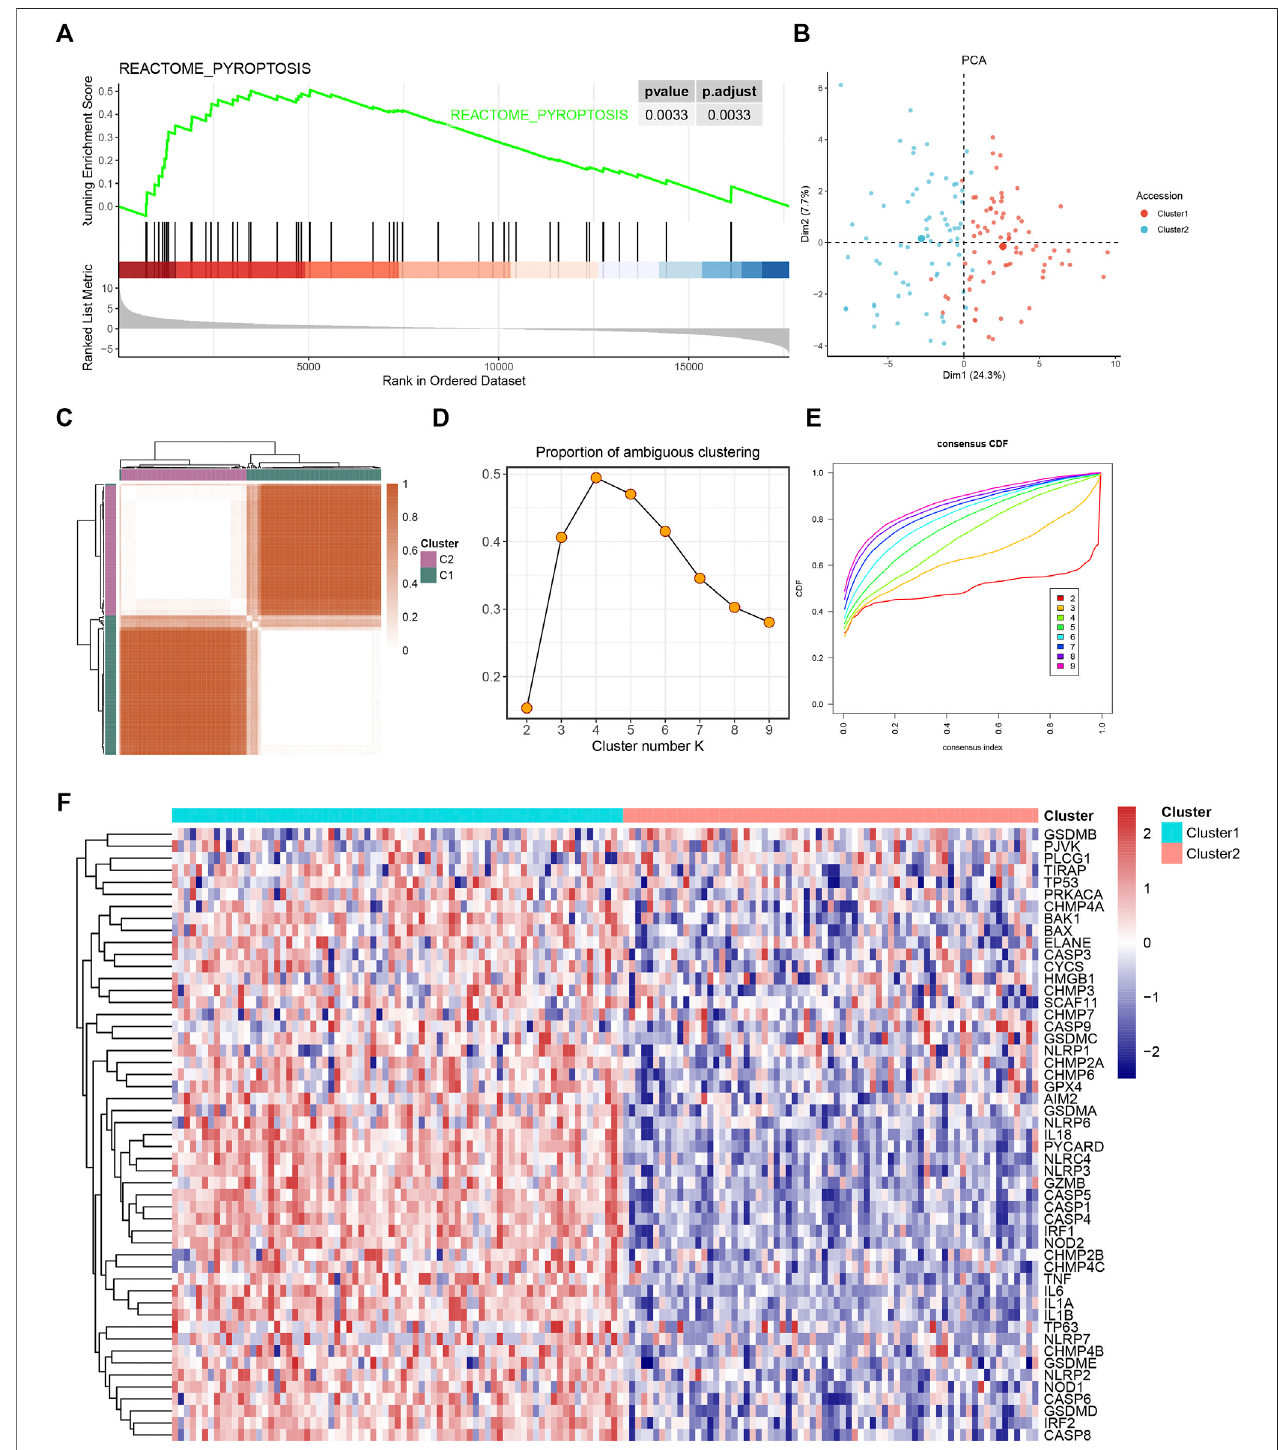
FIGURE 1 | The gene set enrichment analysis (GSEA) and consensus clustering of pyroptosis-related gene set. (A) Gene set enrichment analysis showed pyroptosis-related signatures signi fi cantly enriched in glioblastoma (GBM) patients. (B) Two-dimensional principle component plot by gene pro fi le of 51 pyroptosis- related genes (PRGs). Each point represents a single sample, with different colors indicating the different clusters. (C) The clustering heatmap of GBM samples when k = 2. (D) The proportionof ambiguousclustering (PAC) score; a lowvalue of PAC implies a fl at middle segment, allowing conjecture of the optimal k (k = 2) by the lowest PAC. (E) The cumulative distribution functions of clustering heatmaps for each k (indicated by colors). (F) The pyroptosis cluster of GBM patients in The Cancer Genome Atlas (TCGA) cohort.